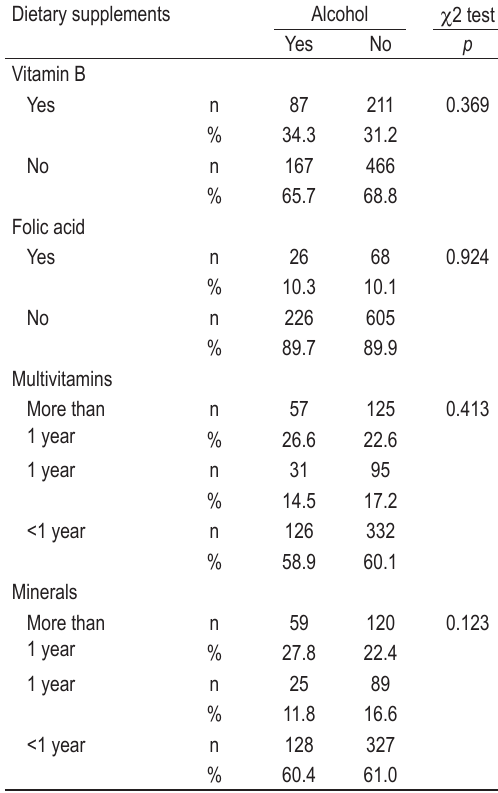
TABLE 1. Socio‑economic status of students TABLE 2. Relationship between alcohol drinking (yes/no) and consumption of dietary supplements in